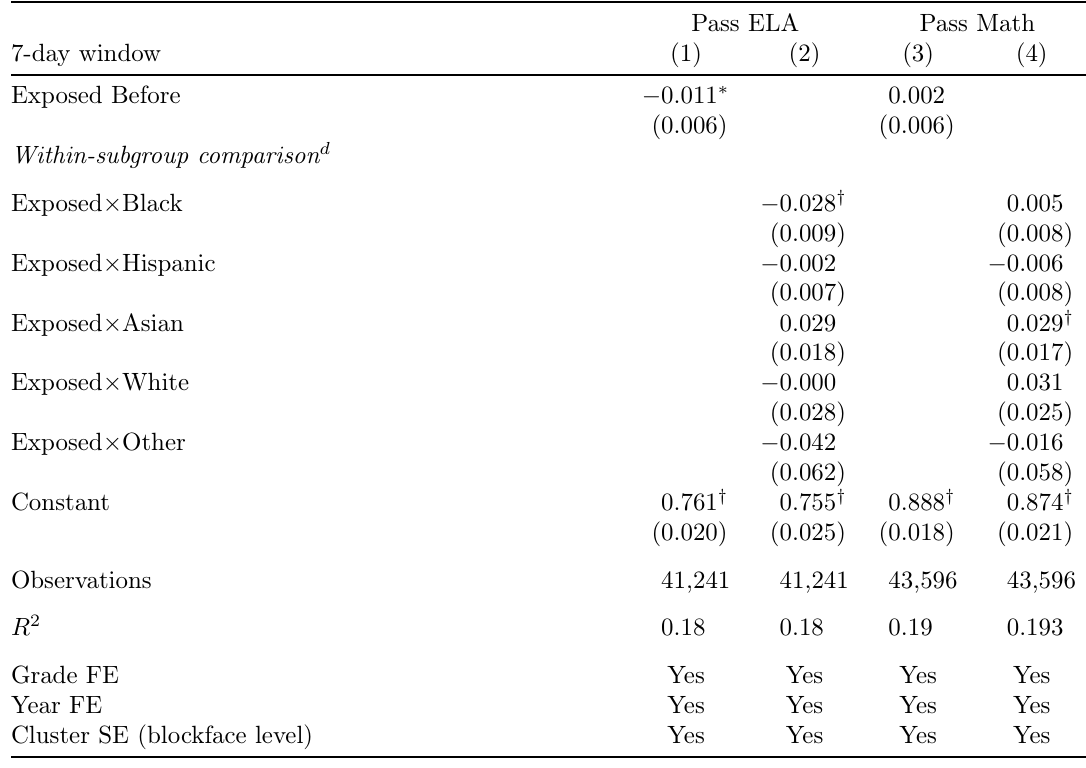
Table 6: Pass Exam Models (School Years 2004/2005 to 2009/2010): Impact of Exposure to Violent Crime a and in a High-Poverty Sample